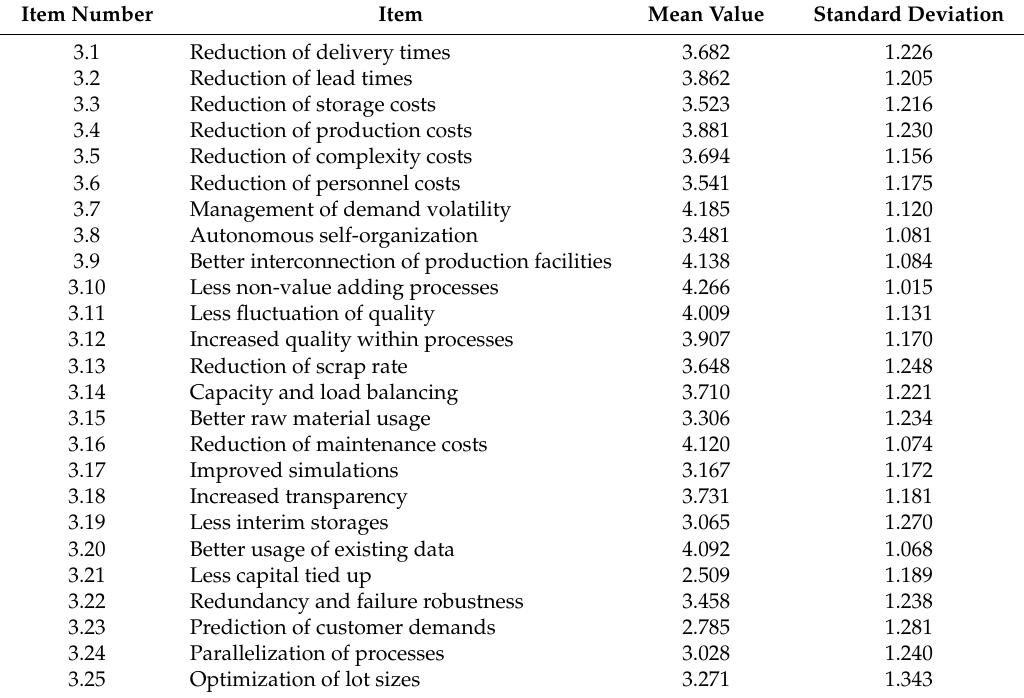
Table A3. Potentials of new business model features for the